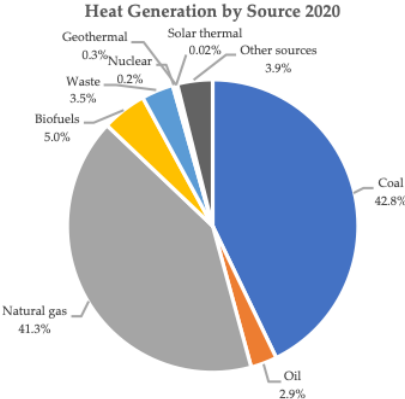
Figure 8. Heat Generation by Source 2020 (authors’ forecasts).